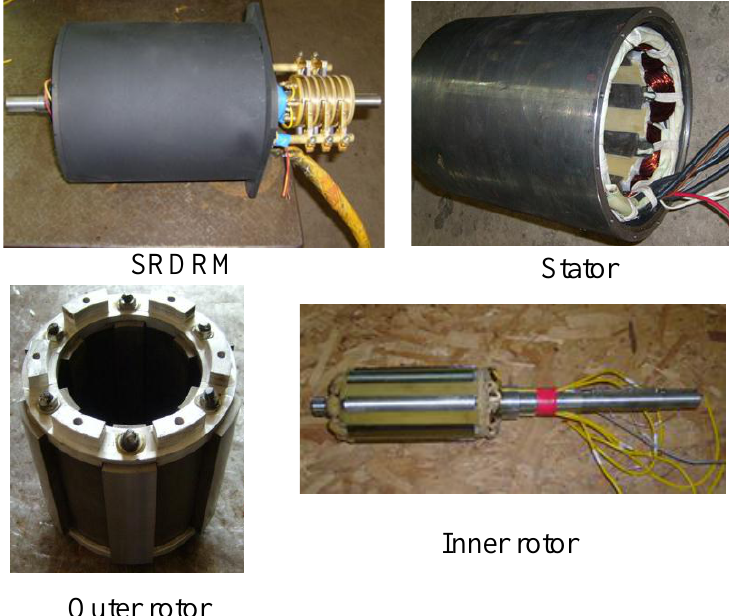
Figure 28. Appearance of the prototype and stator/outer rotor/inner